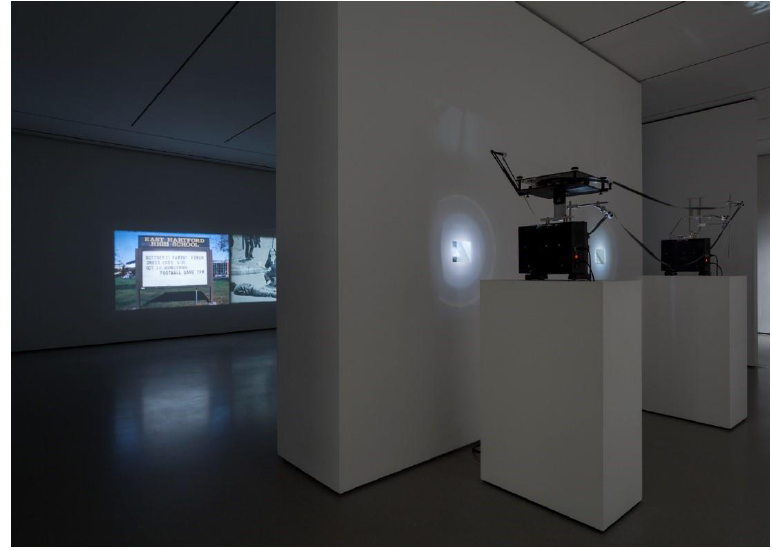
Figure 9. Kerry Tribe, H.M . (2009), double projection of a single 16 mm film, 18:30 min loop. Installation view, Museum of Modern Art, New York. Photo: Thomas Griesel.